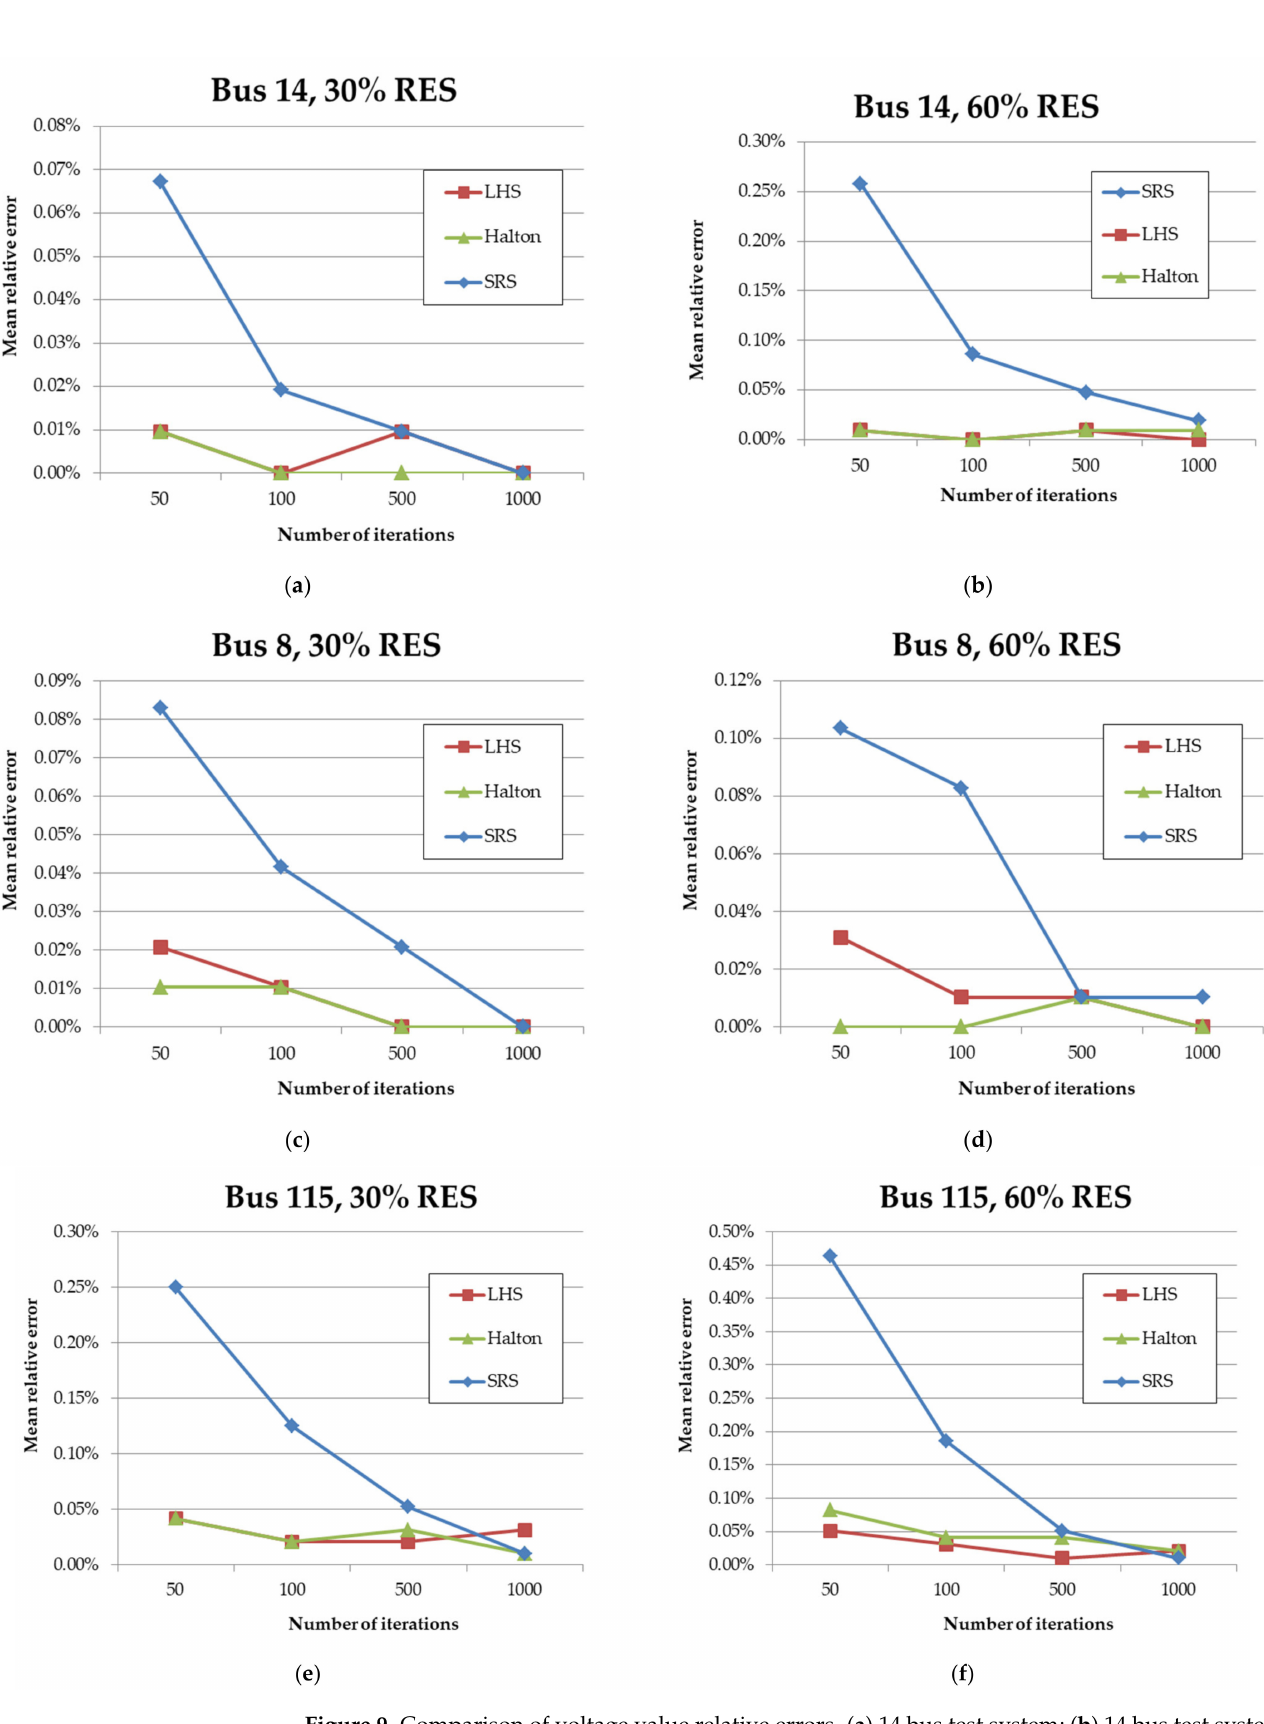
Figure 9. Comparison of voltage value relative errors. ( a ) 14 bus test system; ( b ) 14 bus test system; ( c ) 30 bus test system; ( d ) 30 bus test system; ( e ) 118 bus test system; and ( f ) 118 bus test